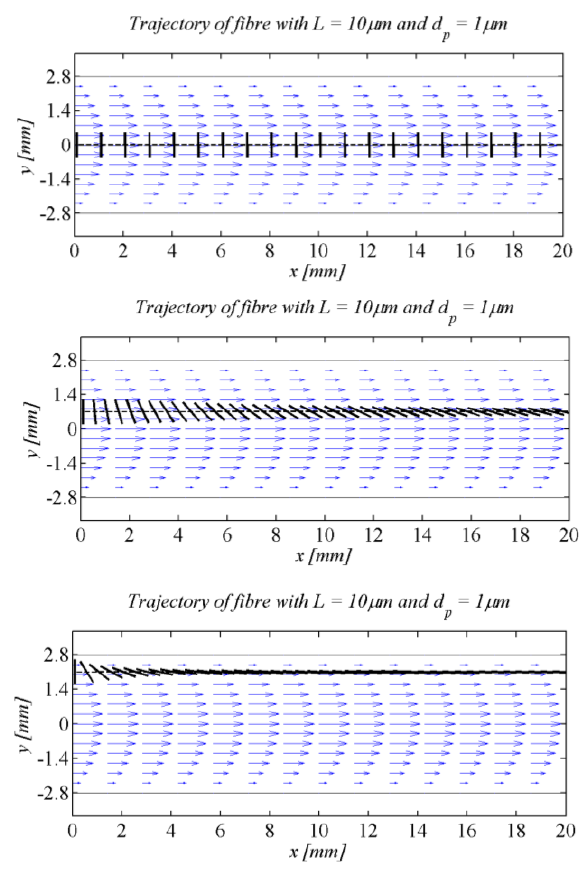
Fig. 3. Trajectory and orientation of fibres with initial positions of y/H = 0.001, y/H = 0.25 and y/H = 0.75